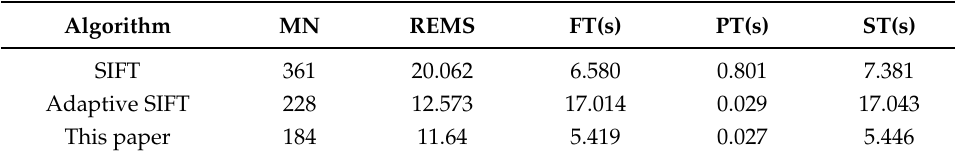
Table 5. Comparison of matching results of different illumination images.